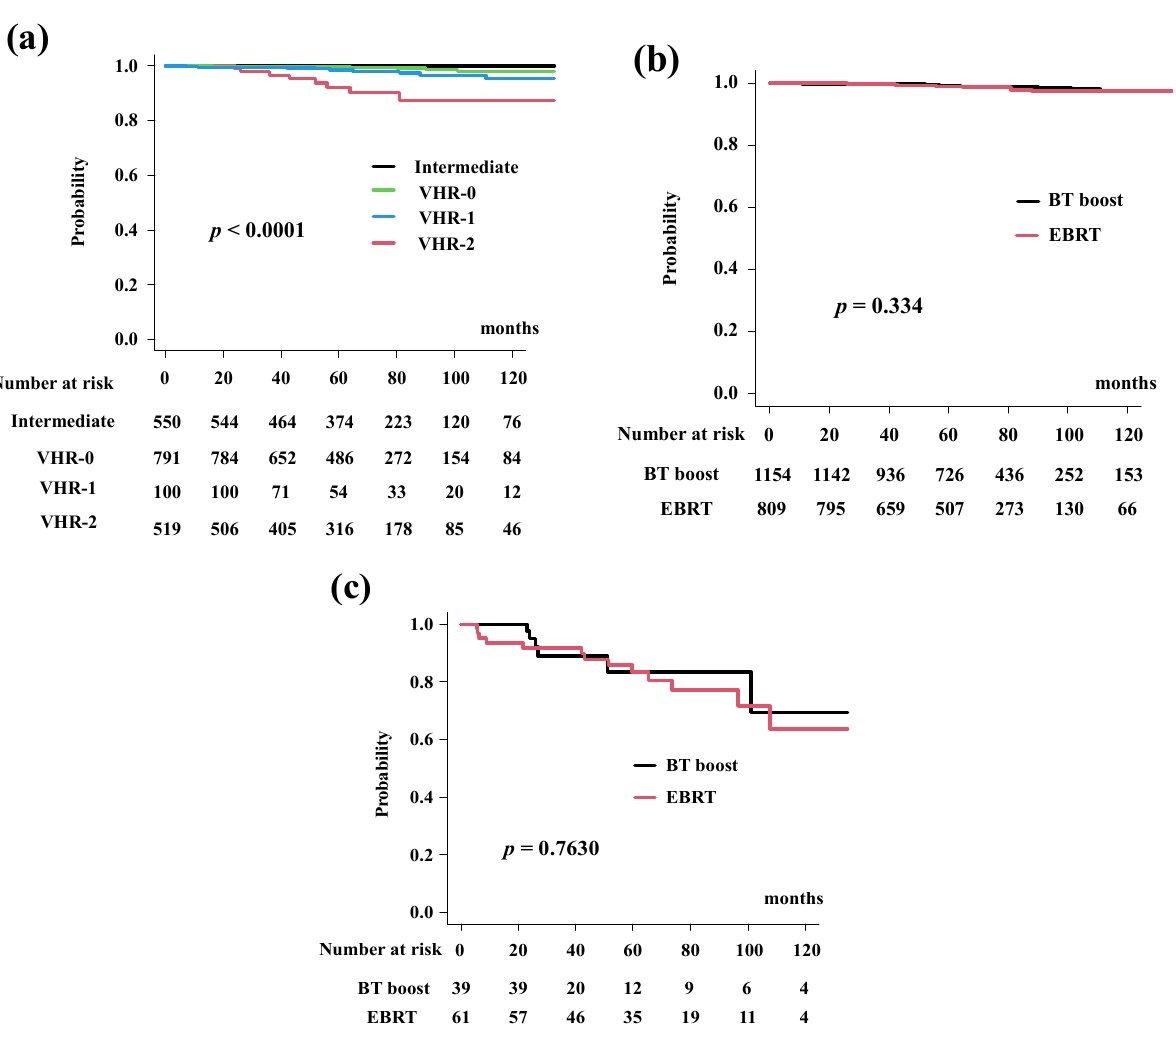
Figure 4. Prostate cancer specific survival rate (PCS). ( a ) PCS according to risk stratification.